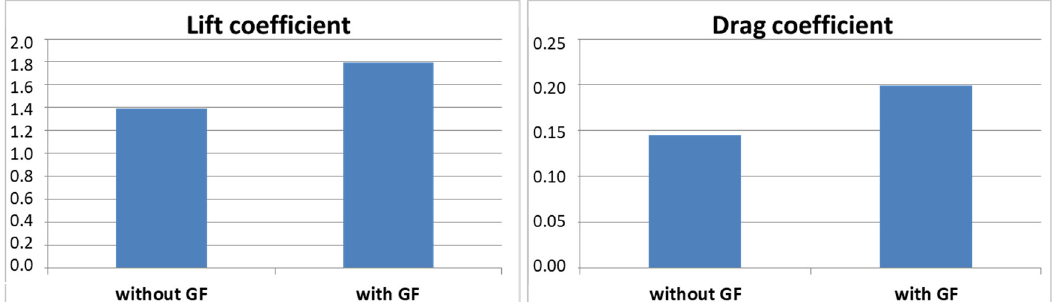
Figure 5. Lift and drag coefficients of the complete aileron with and without GF.